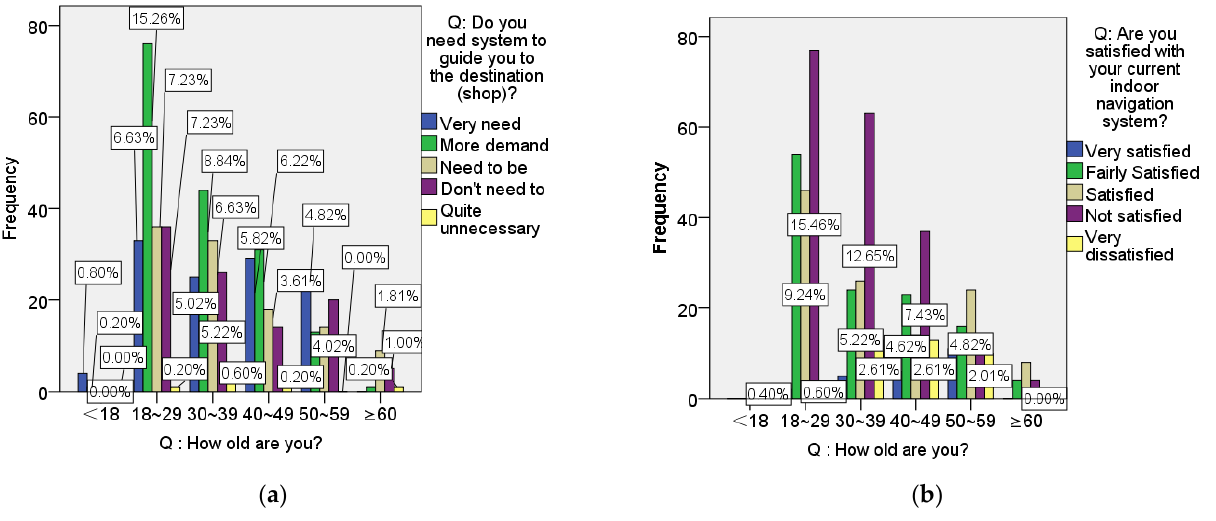
Figure 15. Frequency comparison between “Age” and personal data related to shopping behavior. ( a ) Do you need a software system to guide you to the des-tination store; ( b ) Are you satisfied